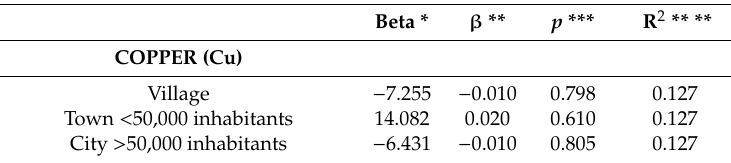
Impact of Sociodemographic Indicators on Microelement Levels in the Multivariable Linear Regression #